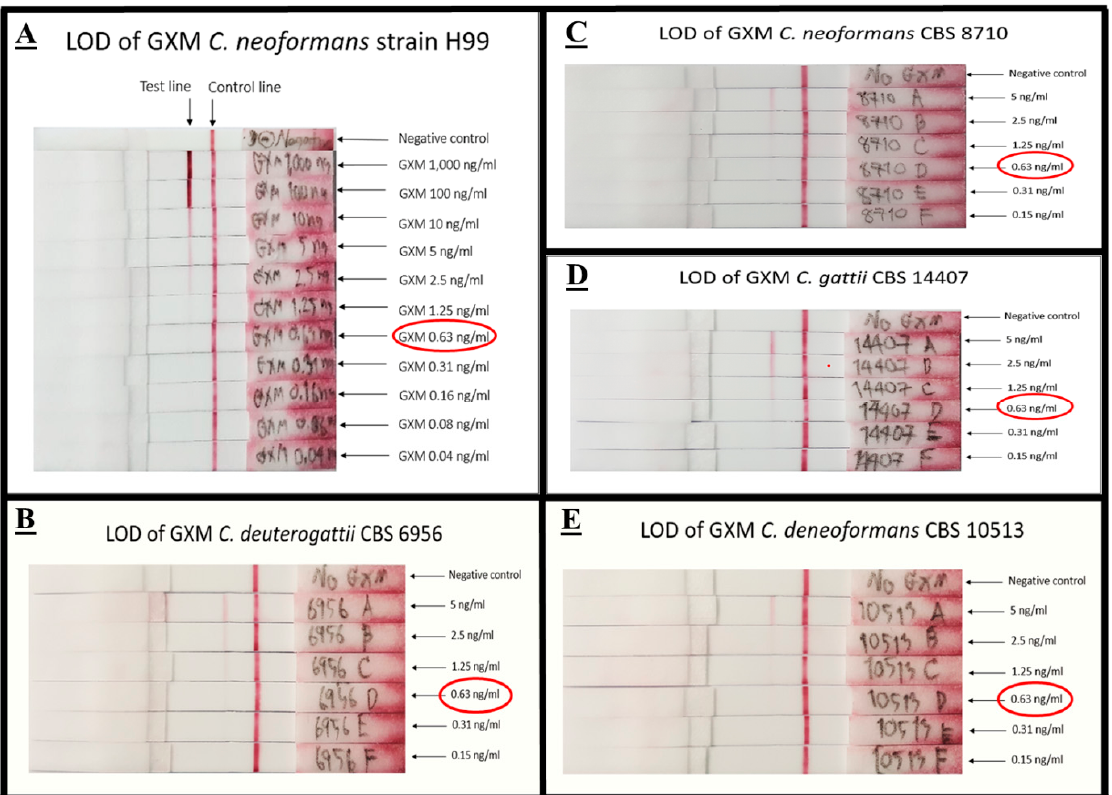
Figure 6. The LOD of mAb 18B7 sandwich ICT strip. The mAb 18B7 sandwich ICT strip was tested with GXM capsular antigen of serotype A, strain H99 ( A ), serotype B, strain CBS 6956 ( B ), serotype A, strain CBS 8710 ( C ) serotype B, strain CBS 14407 ( D ), and serotype D strain CBS 10513 ( E ). The ICT was measured by naked eye visual observation with three laboratory persons. The LOD of the mAb 18B7 sandwich ICT strip was 0.63 ng/mL for all cryptococcal serotypes. The red circle indicates the LOD was recorded.